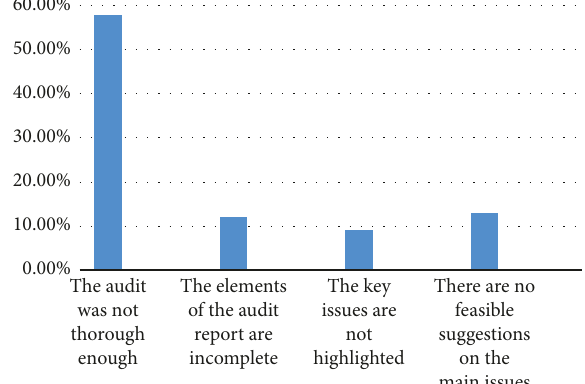
Figure 4: Statistical table of internal audit quality report of an insurance company.